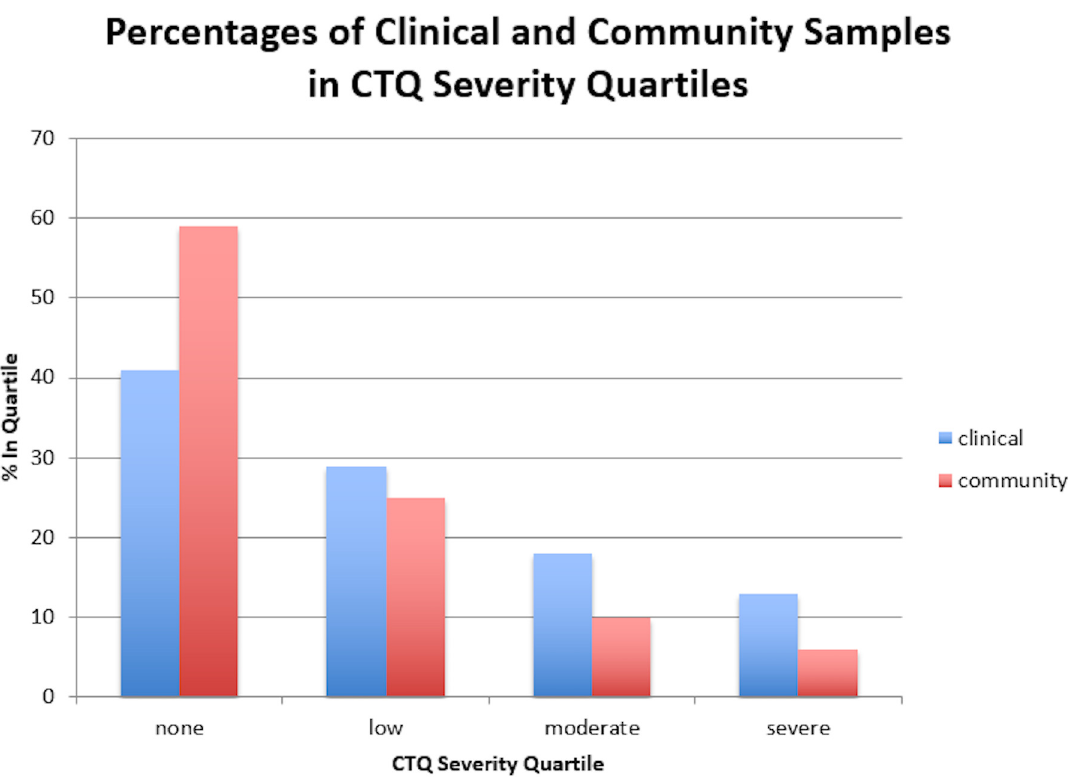
Fig 1. Percentages of Clinical and Community Samples in CTQ Severity Quartiles. X-Axis: Quartiles of childhood maltreatment based on total CTQ scores: none, low, moderate, and severe. Y-Axis: The percentage of subjects whose CTQ scores fall into that severity quartile. Within each quartile, the bar depicted on the left represents the percentage of clinical subjects (n = 5429 – 5876), and the bar on the right represents the percentage of community subjects (n = 12432 – 12915). Notably, the largest relative percentage of community subjects was in the “ none ” maltreatment quartile. That trend was reversed in the “ moderate ” and “ severe ” categories, where double the percentage of subjects were in the clinical group.